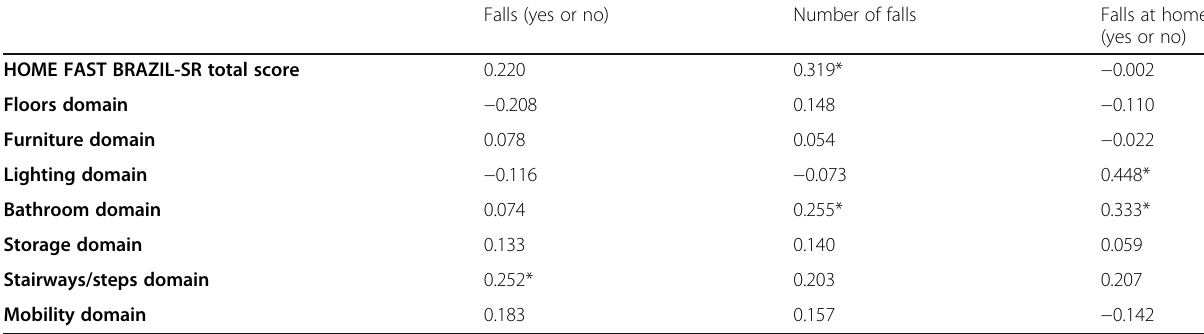
Table 3 Spearman Correlation between HOME FAST BRAZIL-SR and your domains with history of falls, Curitiba, PR, Brazil, 2017 Falls (yes or no) Number of falls Falls at home (yes or